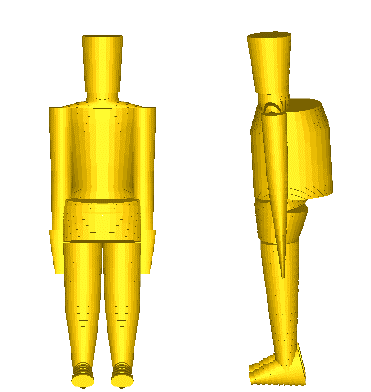
Fig. 7 Body configuration of